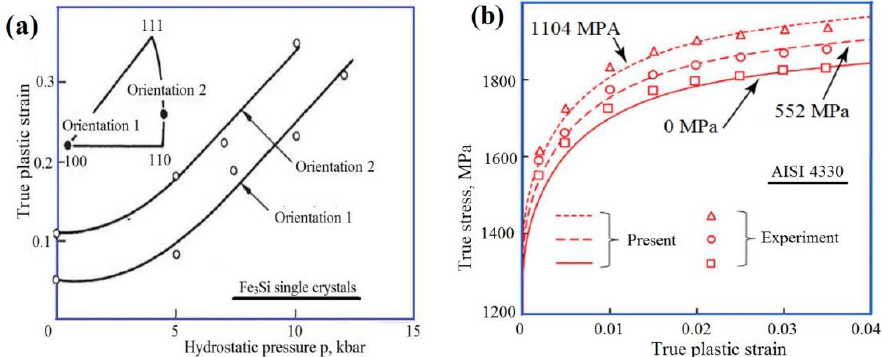
Figure 10. The effect of applied hydrostatic pressure p on true plastic strain and stress in compres- sion tests of Fe 3 Si single crystals [20] ( a ) and AISI 4330 steel [21] ( b ). tests of Fe 3 Si single crystals [20] ( a ) and AISI 4330 steel [21] ( b